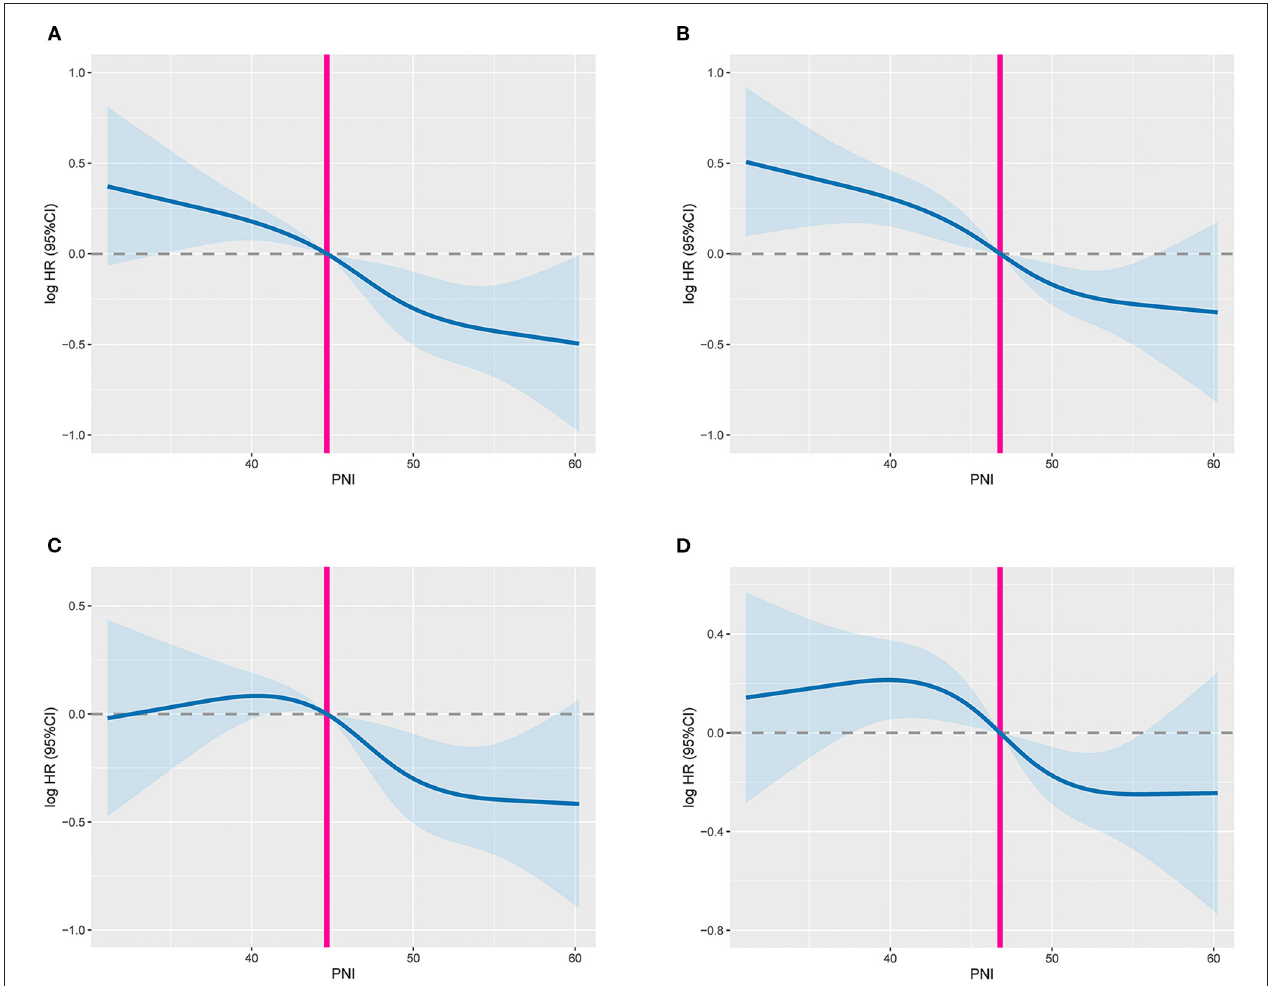
FIGURE 1 | The dose-response relationship between PNI and survival in CRC patients. (A) Unadjusted RCS of PFS; (B) unadjusted RCS of OS; (C) adjusted RCS of PFS; (D) adjusted RCS of OS; The model adjusted for gender, age, BMI, hypertension, diabetes, pT stage, pN stage, clinical distant metastasis, tumor location, tumor size, perineural invasion, vascular invasion, macroscopic type, and histological